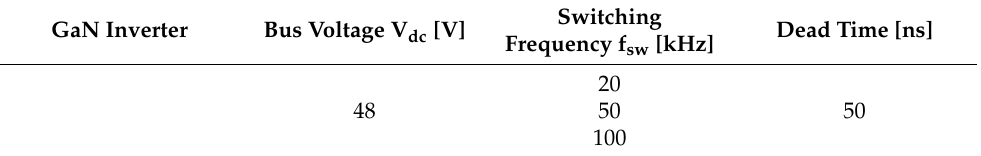
Table 2. Inverter operative test